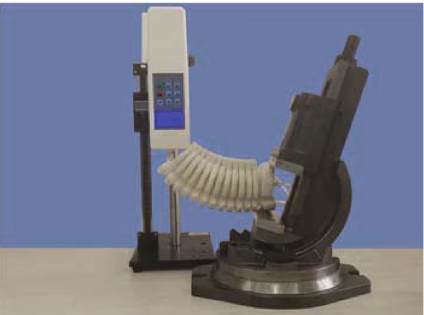
Figure 16: Driving torque measure experiment of pneumatic soft- bodied bionic actuator.